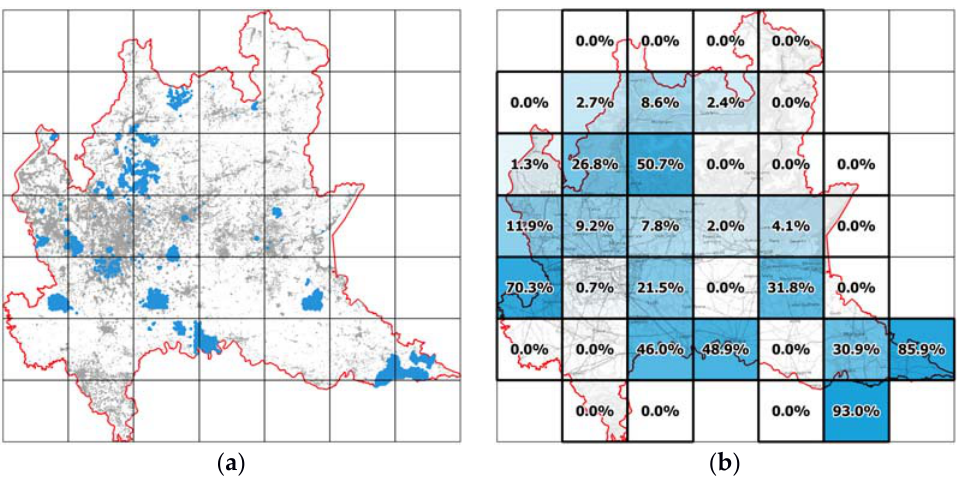
Figure 7. ( a ) OSM buildings identical to the DBT buildings; ( b ) percentage of identical buildings in each cell with respect to the total number of OSM